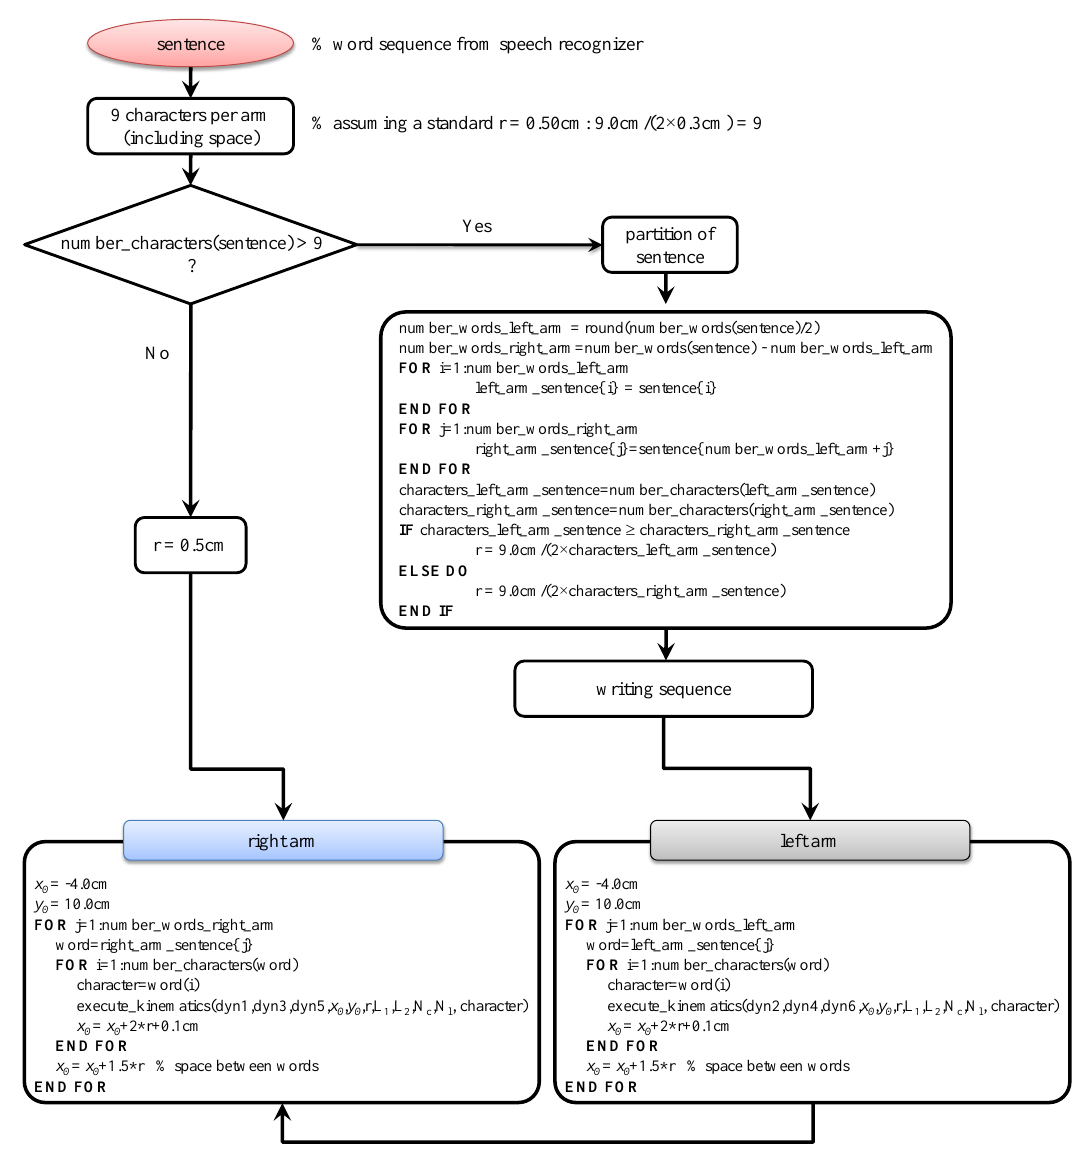
Figure 10. Pseudo-code of the word definition scheme, adjustment of radius, and execution of kinematics for both Bioloid’s